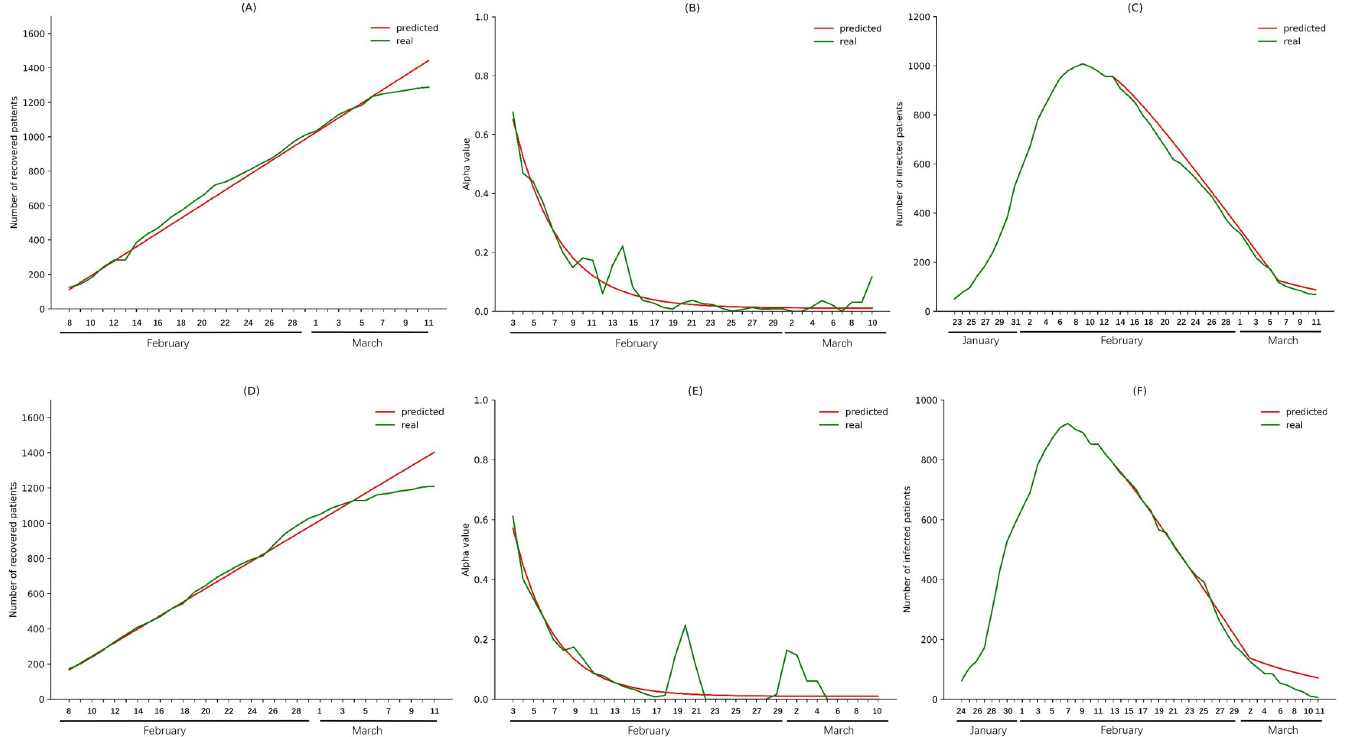
Fig 1. Validation of the modified SIR model using data from Guangdong and Zhejiang provinces. The φ values from February 3 to February 12 (before nationwide intensive community screening but after Wuhan city lockdown) were used to predict φ values from February 13 to March 11 for Guangdong (A) and Zhejiang (D). The α values from February 8 to February 12 (before nationwide intensive community screening but after Wuhan city lockdown) were used to predict α values from February 13 to March 10 for Guangdong (B) and Zhejiang (E). Predicted α values and φ values were used to predict the number of infections in from February 14 to March 11 for Guangdong (C) and Zhejiang